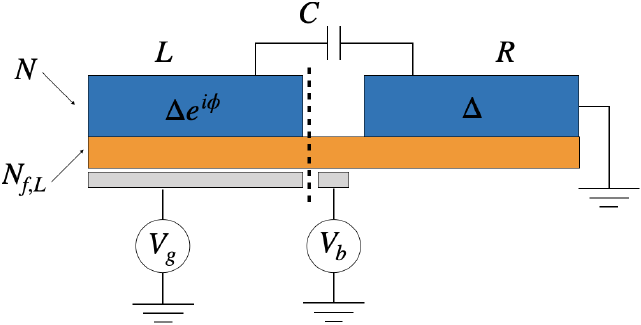
Figure 1: Schematic setup: a semiconducting nanowire proximity coupled to a su- perconductor, forming a Josephson junction shunted by a capacitor and controlled by the gate voltage V . The right half of the wire is connected to a superconduct- g ing ground. The dashed line represents the partitioning of the system used in our theoretical model, see main text for